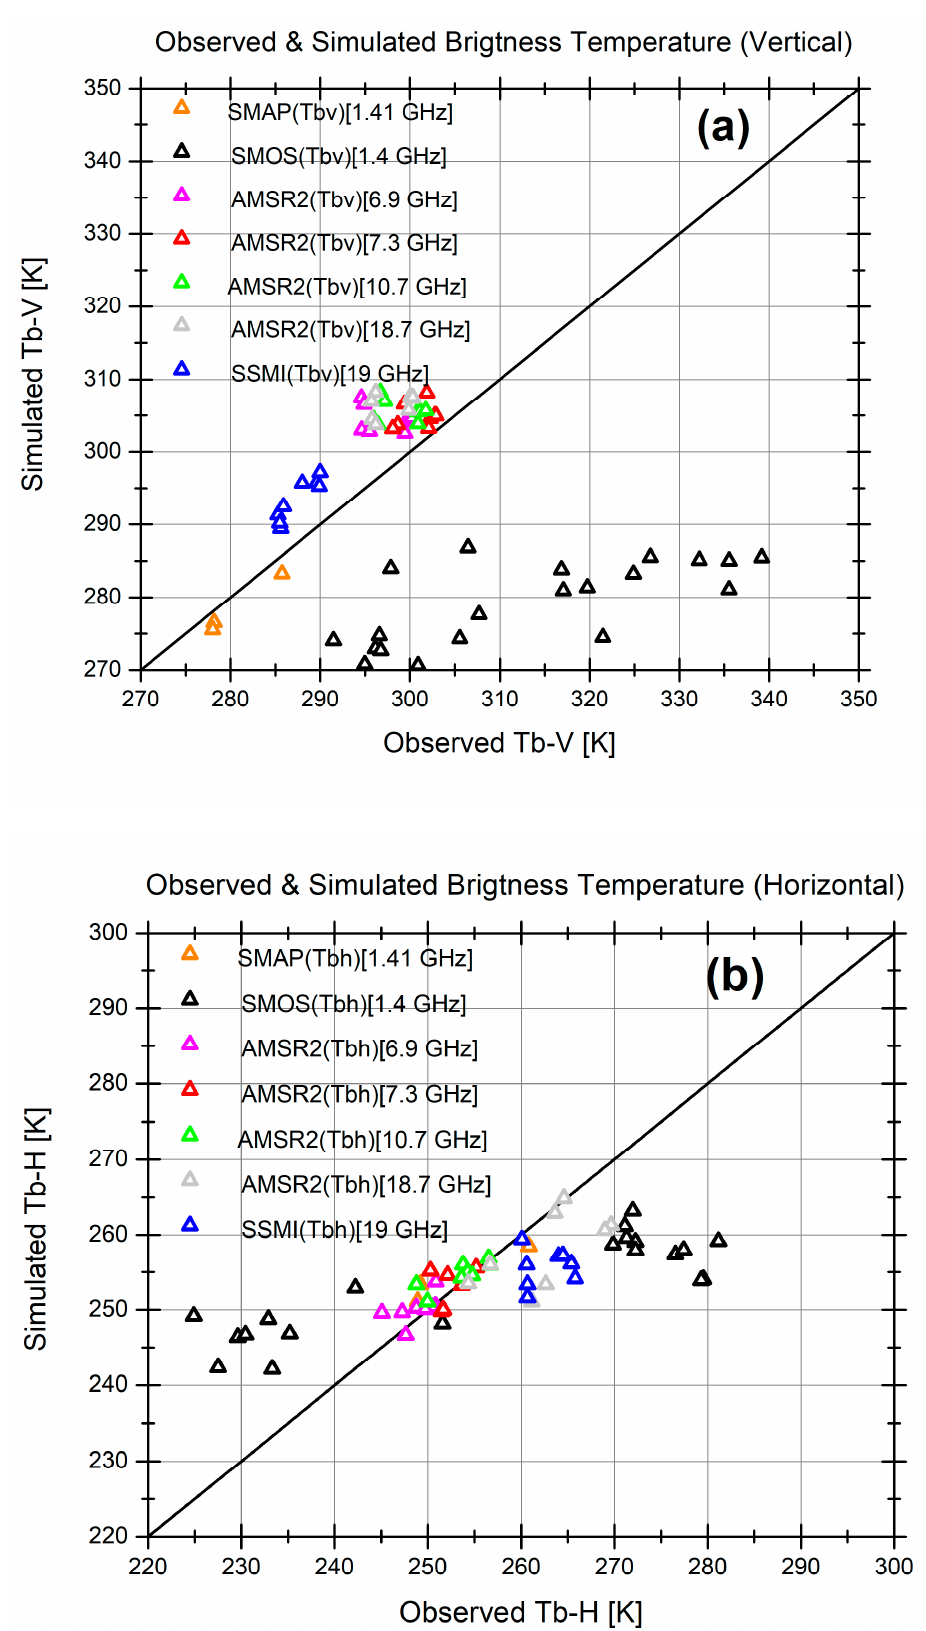
Figure 8. Simulated Tb versus observed Tb for SMAP, SMOS, AMSR2, and SSM / I: ( a ) vertical polarization; ( b ) horizontal